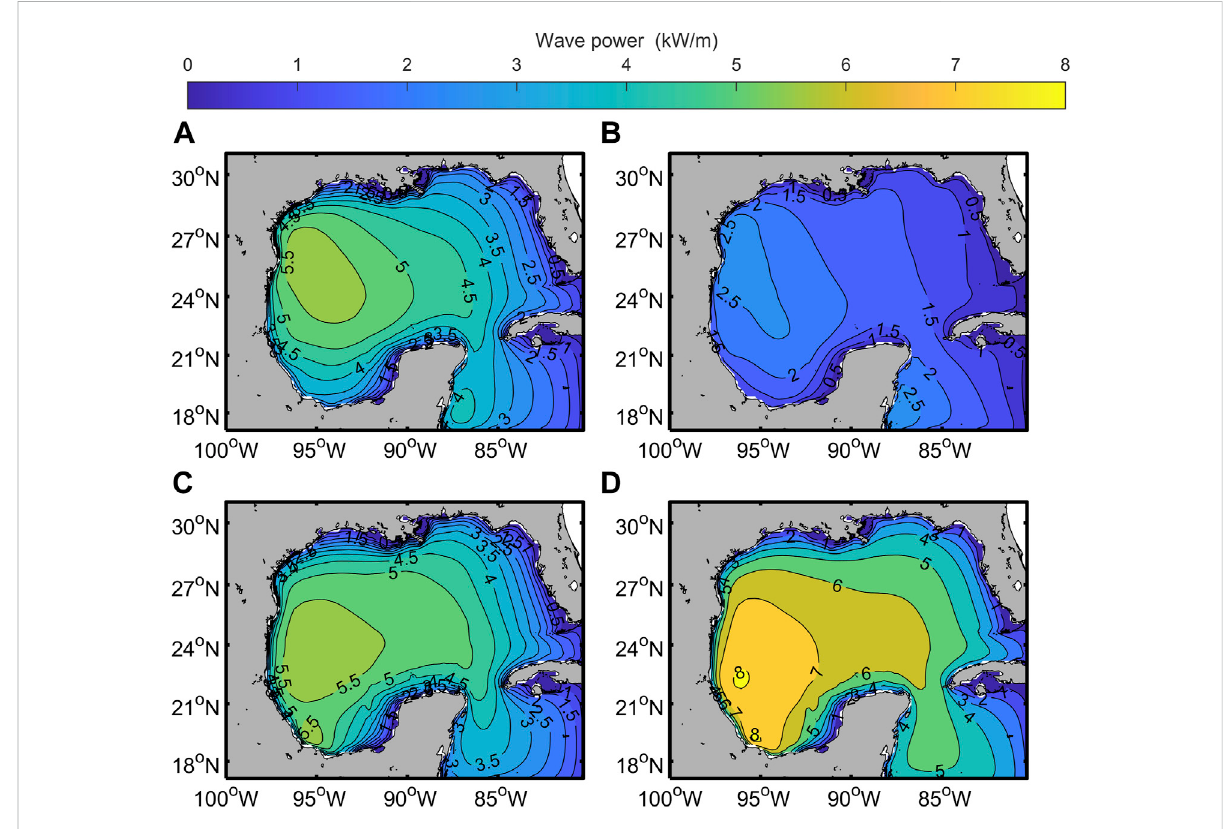
FIGURE 10 Seasonal mean wave power maps: (A) spring; (B) summer; (C) autumn; and (D)